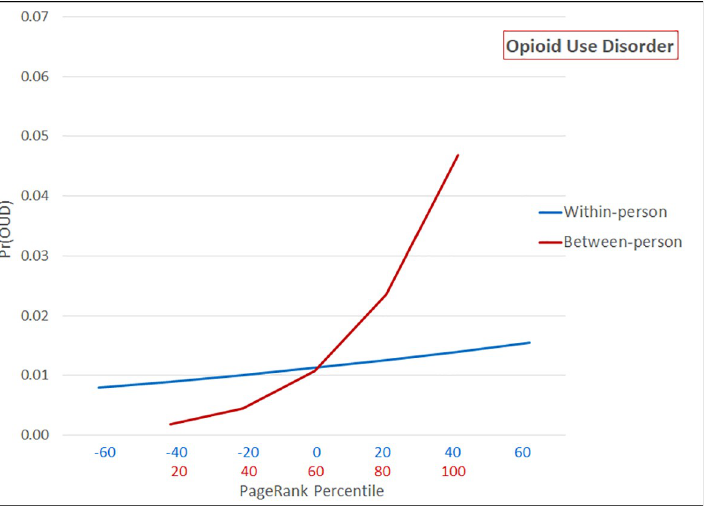
Fig 4. Predicted probability of opioid use disorder as a function of within-person and between-person PageRank percentile (n = 526,914; n obs = 2,107,656).